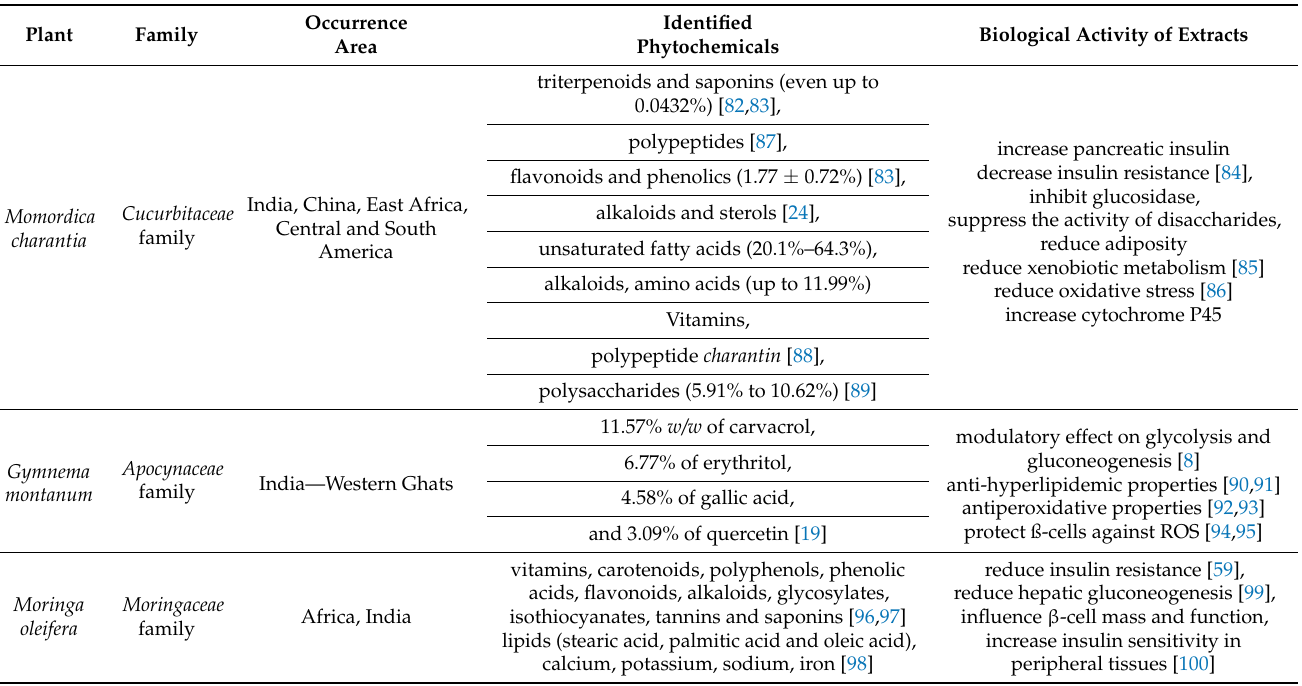
Table 1. M. charantia , M. oleifera and G. montanum and their characteristics.